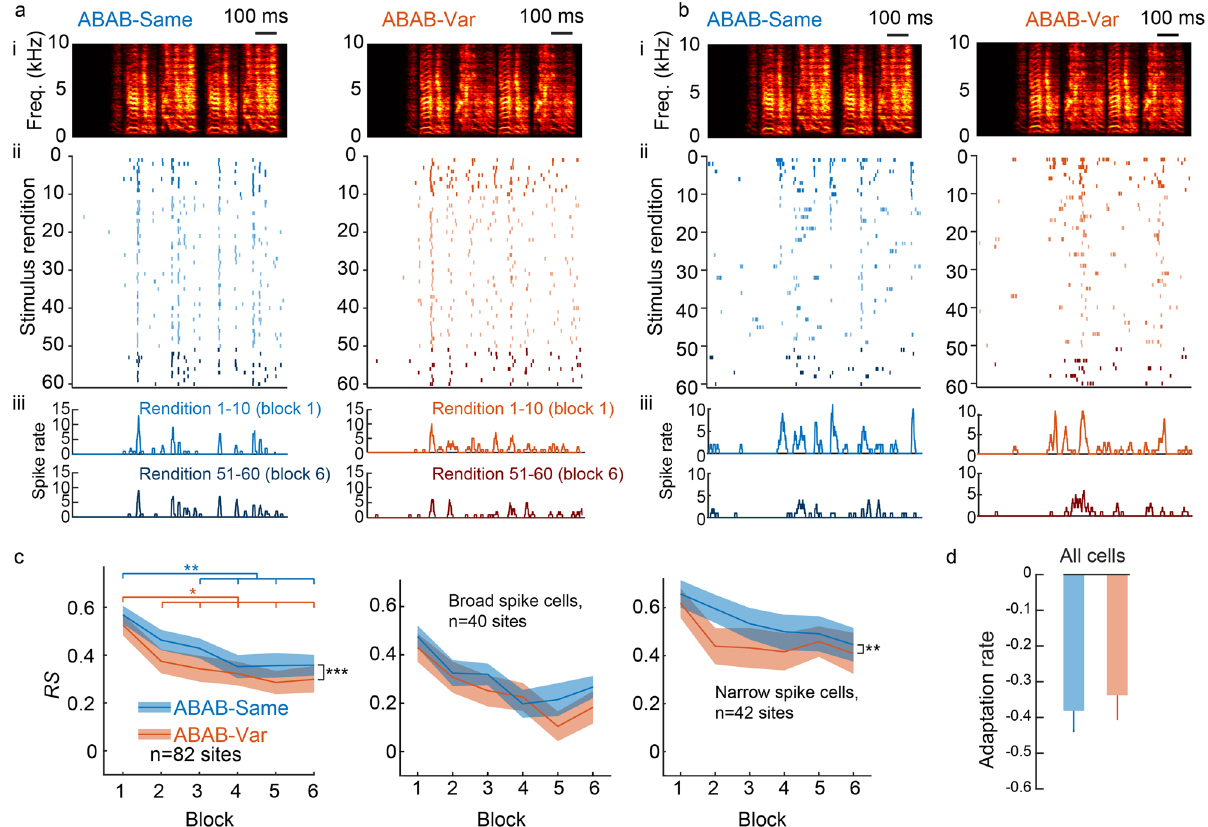
Figure 3. Auditory responses in anesthetized birds. From rendition to rendition, spike timing greatly changed when sequence variants (ABAB-Var series) were played back. No such changes were observed when the same sequence was repeated (ABAB-Same series). ( a , b ) Neuronal responses of representative putative narrow spike ( a ) and broad-spike ( b ) cells to playback of ABAB-Same (left panels) and ABAB-Var (right panels) series (spectrogram on top, ai: the sequence repeated 60 times for the ABAB-Same example series and one sequence variant for the ABAB-Var example series) are shown as raster plots (aii and bii, 60 iterations, dark colors for the 10 first and 10 last trials) and peristimulus time histograms (aiii and biii; 10 ms bin width; for the 10 first (top) and the 10 last (bottom) trials) that are time-aligned with sequence spectrograms. ( c ) ABAB-Same series evoked higher responses ( RS values) than ABAB-Same series at the population level (left) and for the sub-population of narrow spike cells (right), but not for broad spike cells (middle). Thick line indicates mean values and shaded area represents SEM. ( d ) Despite of the difference in the response strength, adaptation rate computed over the first ten stimuli presentations, thus indicated that response strength similarly changed with repeated exposure to sequences. Thick line indicates mean values; shaded area represents SEM. Significant difference: * p < 0.05, ** p < 0.01, *** p <